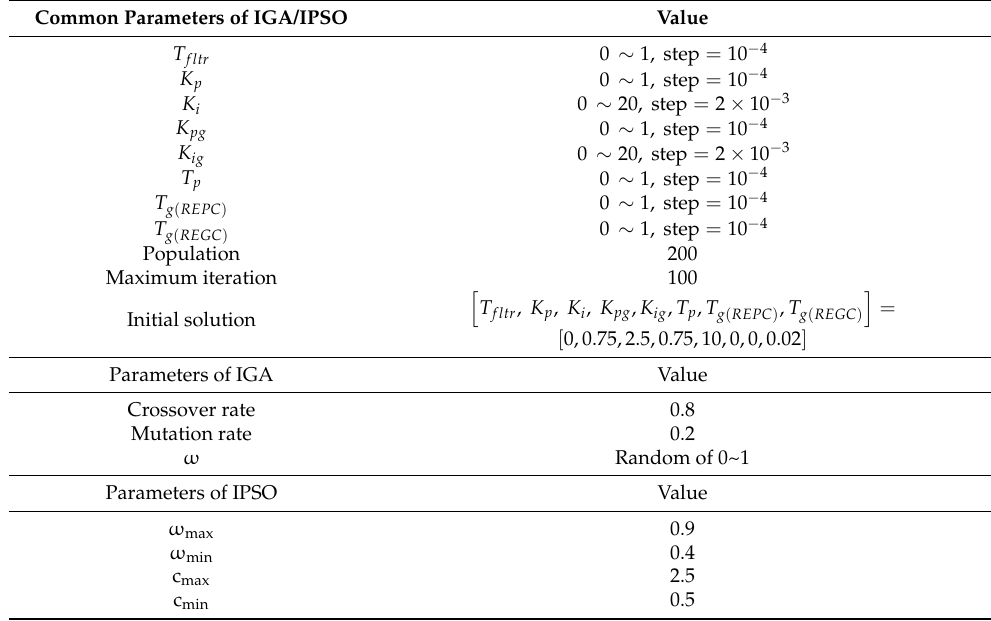
Table 7. The settings of the common parameters of the algorithms. Common Parameters of